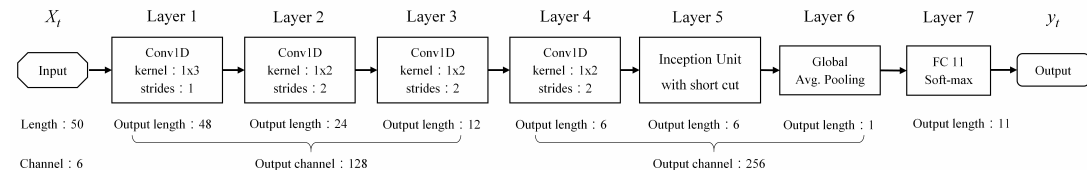
Figure 9. The parameters of Residual PairNet with inception. The input X t has the same dimension and number of channels as those of the input of PairNet. The network contains seven layers, where the inception module with short-cut connection is located at layer 5. The architecture of inception module is revealed in Figure 10. The number of gestures to be classified is Q = 11. Layer 7 is a fully connected layer producing 11